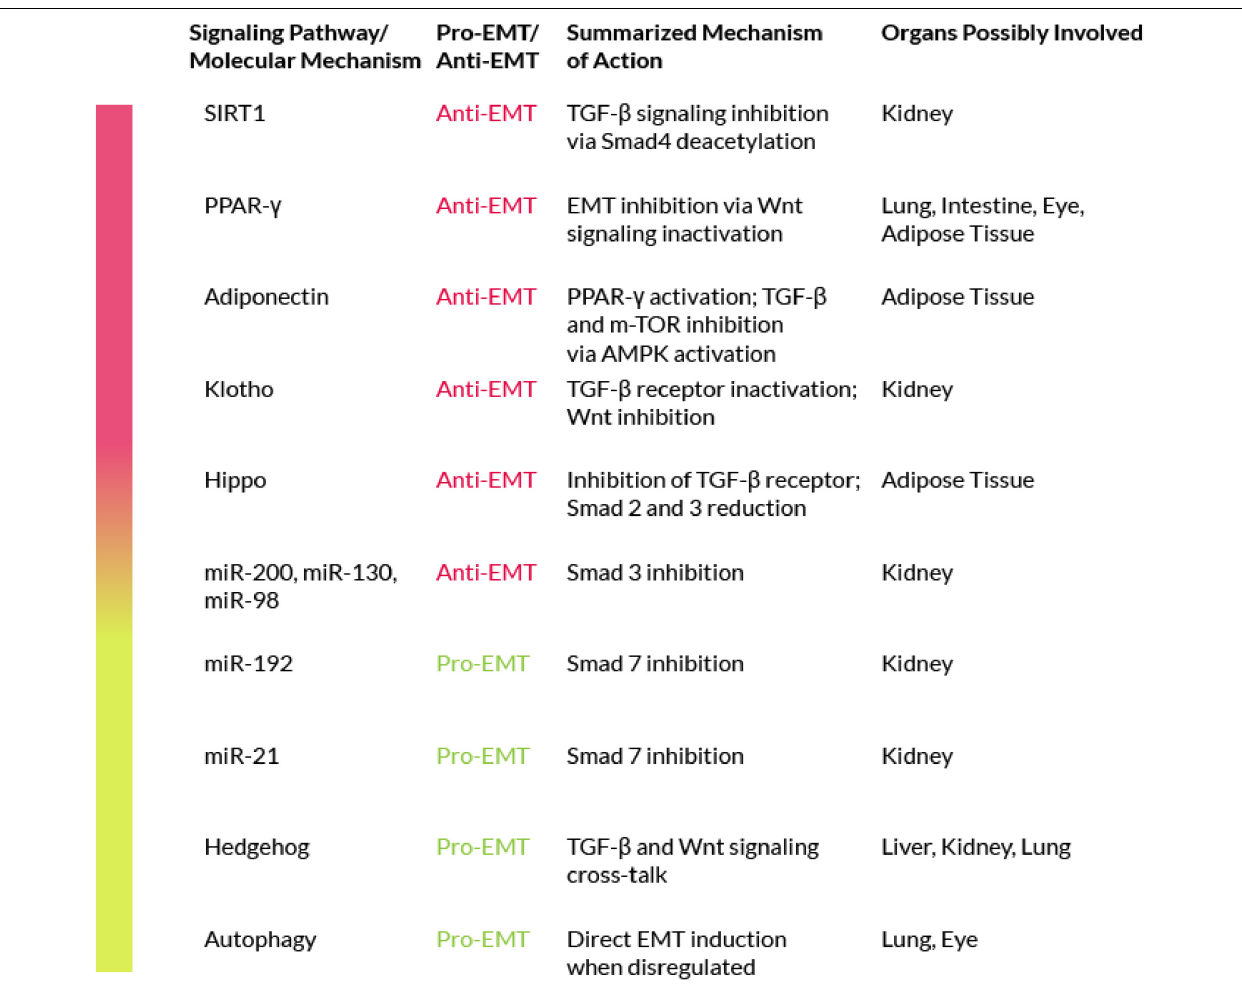
FIGURE 3 | Signaling pathways/Molecular mechanisms that negatively or positively modulate